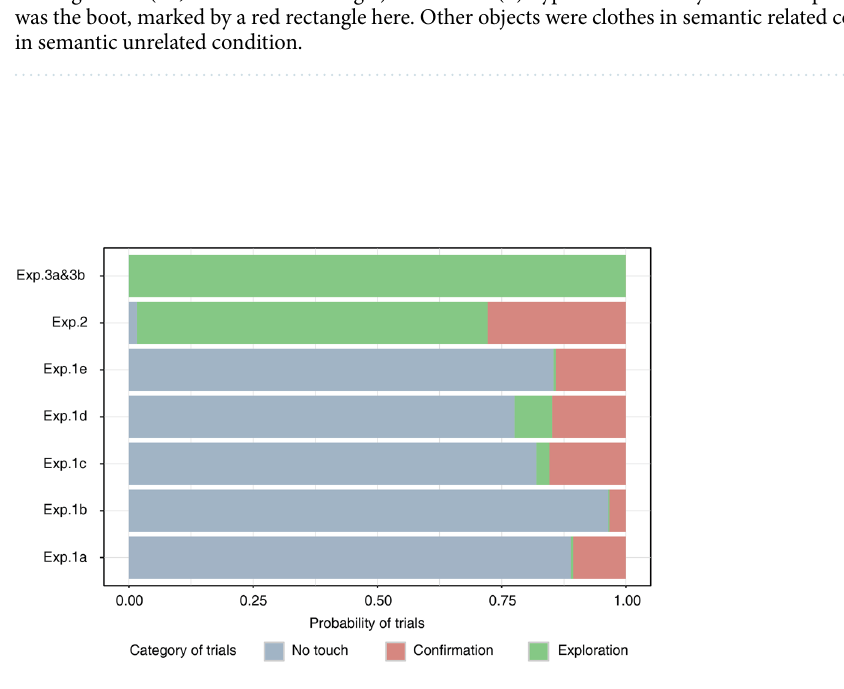
Figure 3. The bar plot of proportion of no touch, confirmation and exploration trials in different experiments. Participants barely touched the screen when searching in arbitrary arrays of items. In contrast, search in natural scenes generated more